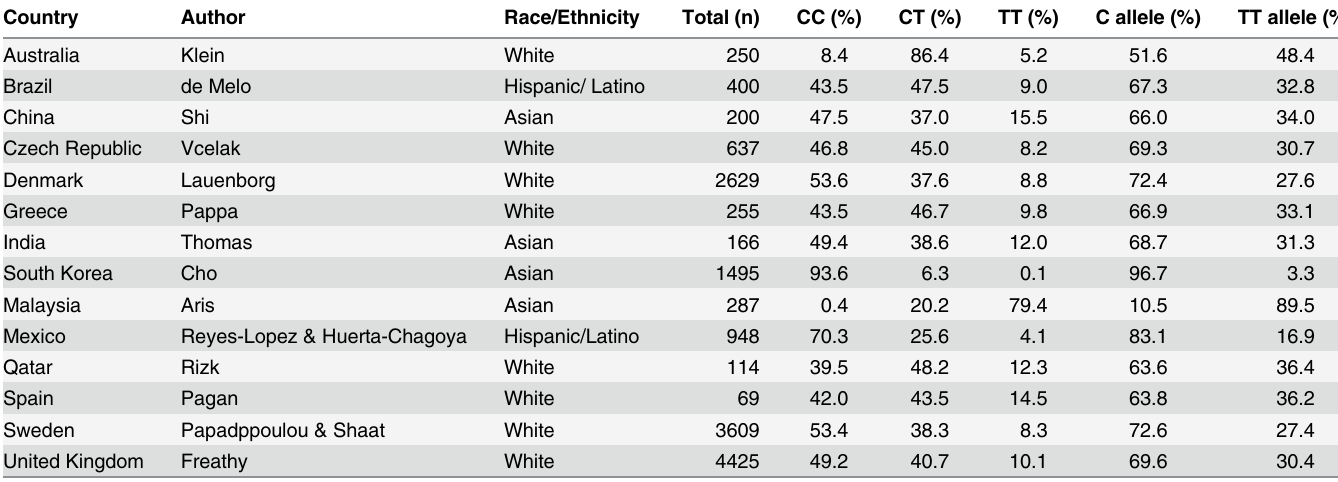
Table 4. The allele frequencies of rs7903146 polymorphism by